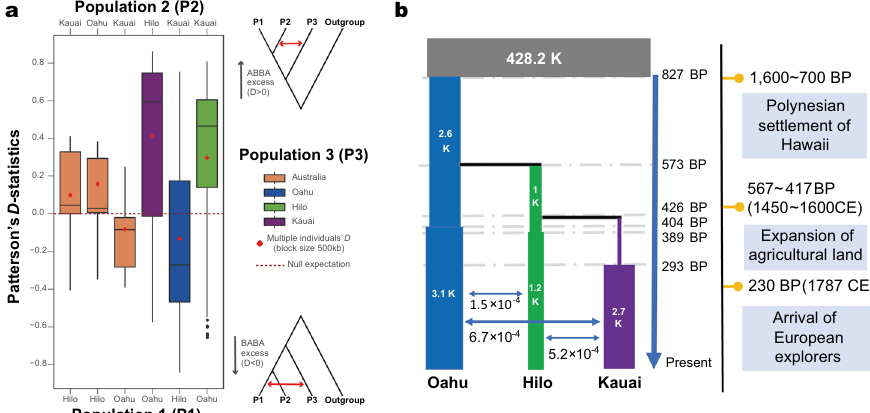
Fig. 2 Extensive gene fl ow among three Hawaiian island populations of T. oceanicus . a ABBA – BABA tests illustrate signi fi cant gene fl ow among all three Hawaiian populations on the X chromosome. Sites used in the test are derived in T. oceanicus compared to the outgroup ( T. commodus ) but differ among P1 and P2 T. oceanicus individuals. Tests with Australian T. oceanicus populations are included as control comparisons (left three bars) and the plot shows all possible topological permutations of the three Hawaiian island populations relevant for the ABBA – BABA test (right three bars). The null expectation of no gene fl ow is indicated by D = 0. Positive D indicates an excess of shared derived alleles — evidence for greater gene fl ow — between populations 2 and 3 in the comparison (ABBA excess), whereas negative D indicates evidence for greater gene fl ow between populations 1 and 3 in the comparison (BABA excess). The signi fi cance of gene fl ow among island populations was also supported by all comparisons between all Hawaiian scenarios and Australian scenarios (two-sided t -tests: all P < 0.001; n = 700 independent D -values for each Australian control; n = 1000 each for Kauai and Hilo; n = 2000 for Oahu. Statistical details are provided in Supplementary Table 4). Box plots show upper quartile, median, and lower quartile values, 1.5× interquartile ranges, and outliers. Multiple individuals ’ D tests using a smaller block size are represented by red diamonds. Source data are provided as a Source Data fi le. b The most likely demographic history of Hawaiian T. oceanicus populations reconstructed using Fastimcoal2 indicates recent, extensive gene fl ow among all islands. The ancestral population is shown in grey. Bar width for each population indicates estimated effective population sizes (numbers indicated in each block) and black horizontal lines represent population divergence. Blue horizontal arrows and the numbers underneath them indicate